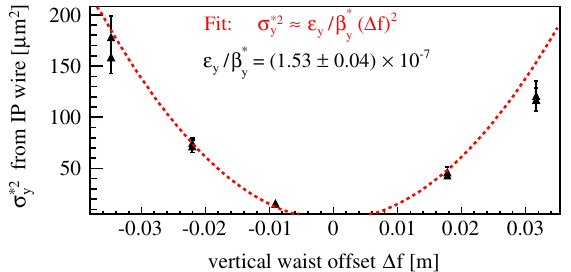
FIG. 3. Example of QD0FF scan for vertical beam parameters evaluation at the IP from the last week of February 2016 operation. Lower cut for the beam size measurement was set to 3 μ m. Only the ratio ε y = β (cid:1) y can be resolved. The effects of dispersion and wire properties are subtracted. Change of the β (cid:1) y value for the maximum waist offset is less than